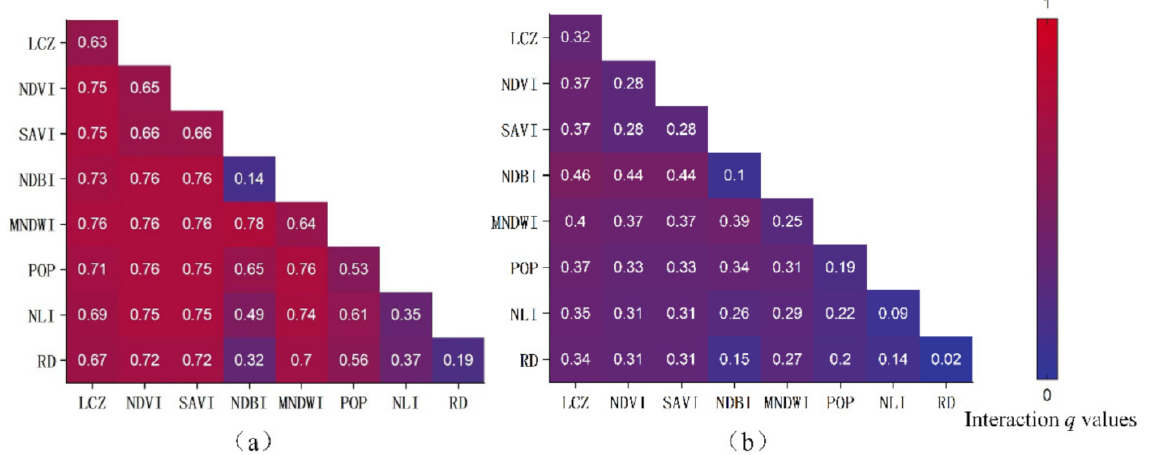
Figure 8. Average interaction q values among potential driving factors on the spatial differentiation of LST in ( a ) summer and ( b )